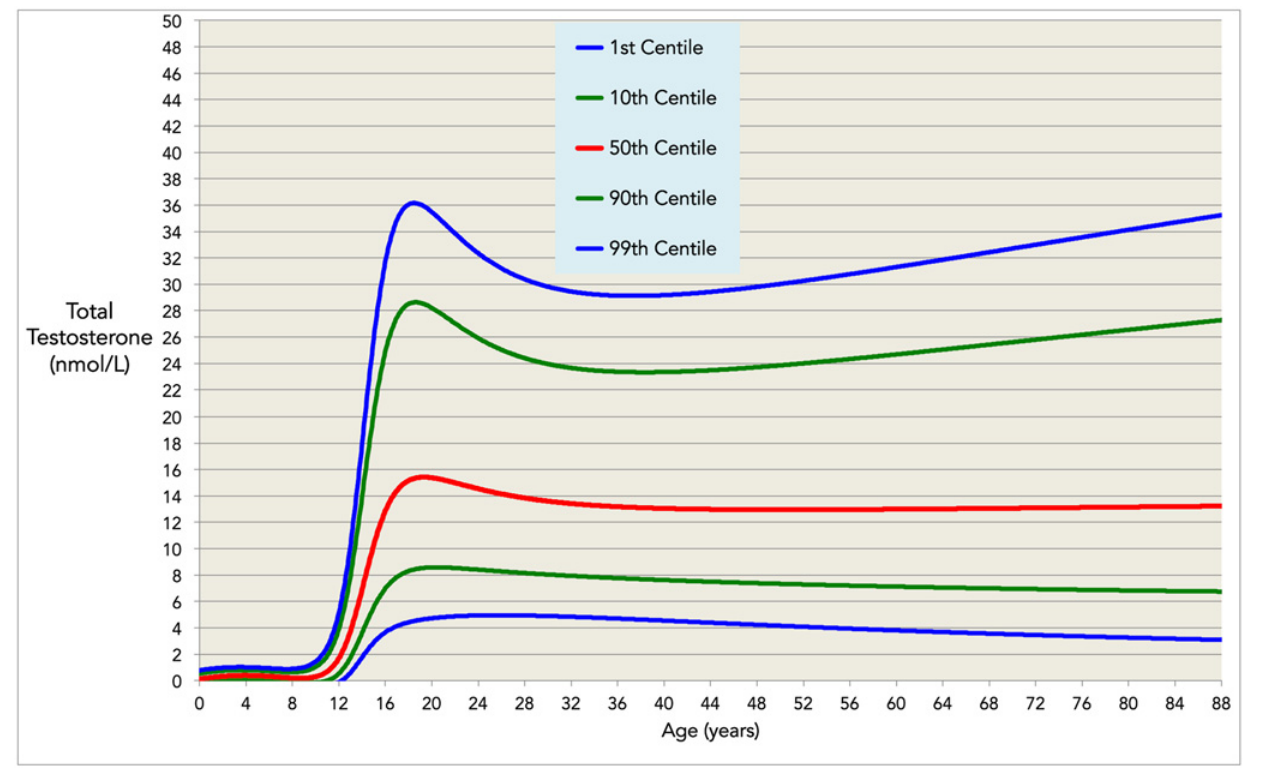
Fig 5. The validated model in centiles. Normative ranges for the model of total testosterone from ages 3 – 88 years. In the average case (red line) total testosterone remains constant for age > 40. However, the variance in normative ranges increases for these ages, with 1 st to 99 th centile ranges of 4.7 – 29.2 nmol/L at age 35 years and 3.1 – 35.2 nmol/L at age 88